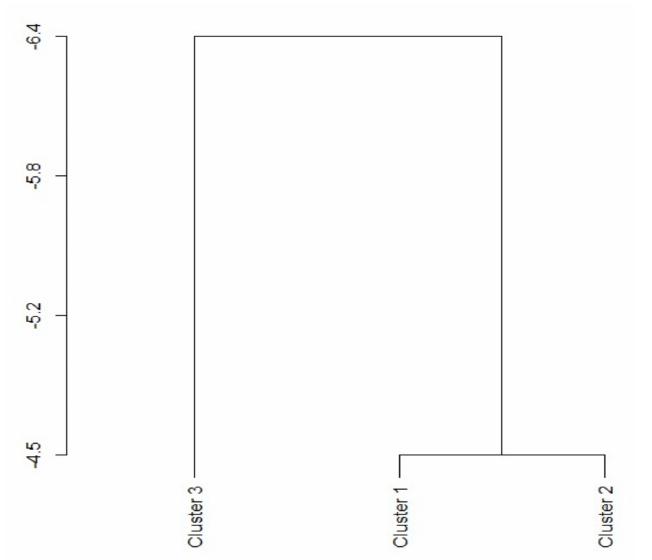
Figure 2. The cluster dendrogram for the ED-process (the three water quality indices dataset).